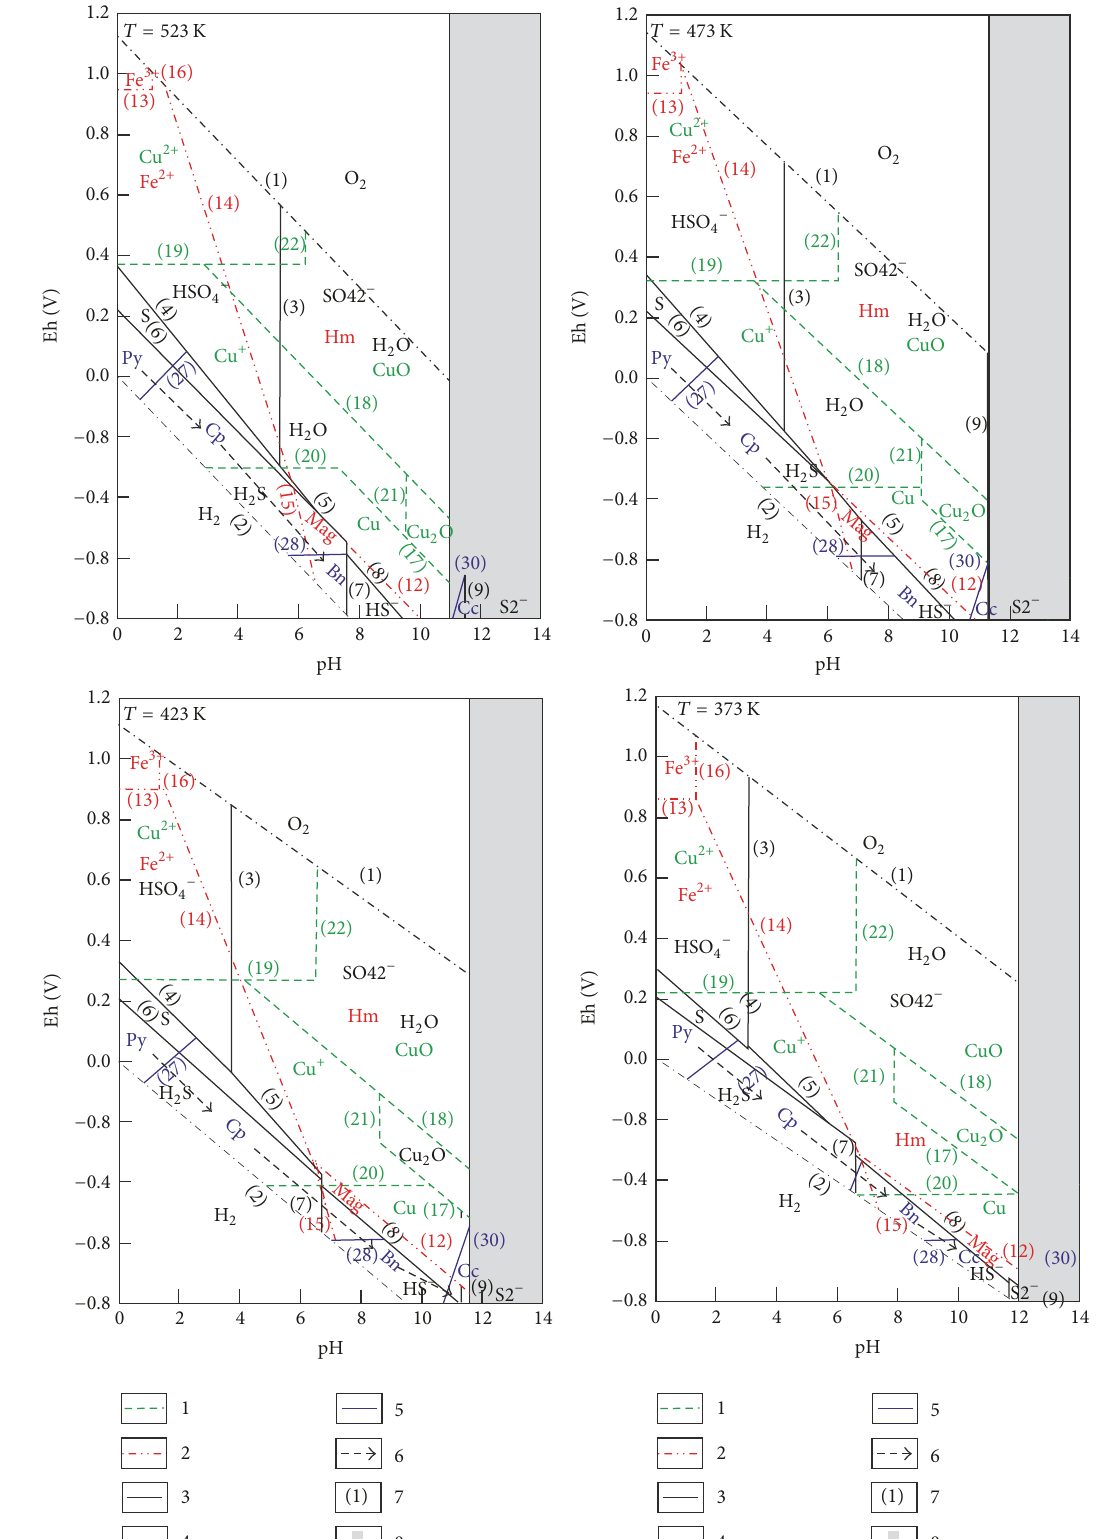
Figure 7: pH-Eh diagram of Cu-O -S-Fe system at 373 K–523 K ( ∑𝑆 = 0.02 𝑚𝑜𝑙/𝐿, ∑ 𝐹𝑒 = 10 − 8 𝑚𝑜𝑙/𝐿, ∑𝐶𝑢 = 10 − 8 𝑚𝑜𝑙/𝐿 ). 1: balance line of 2 Cu; 2: balance line of Fe; 3: balance line of S; 4: balance line of H 2 O; 5: balance line of sulfide; 6: order of sulfide precipitation; 7: number of chemical equations in Table 2; 8: nonexistence in fact because of K at the different temperatures. Py: pyrite; Cp: chalcopyrite; Bn: bornite; H 2 O Cc: chalcocite; Hm: hematite; Mag: